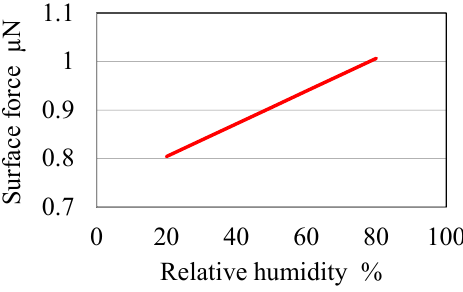
Figure 7. Relationship between relative humidity and surface force (stylus tip diameter: 5 μ m).